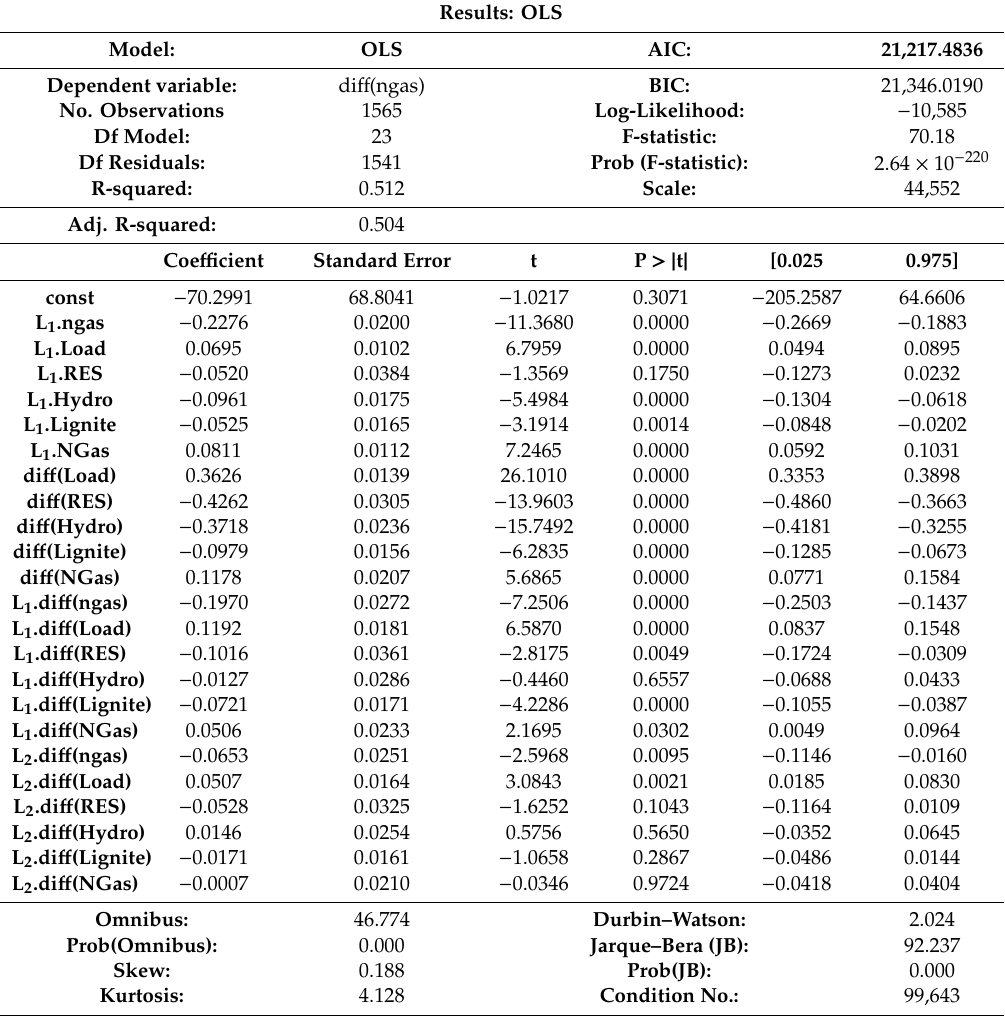
Table A2. Coe ffi cients for the unrestricted error-correction model (ECM) for hour 00:00. Results: